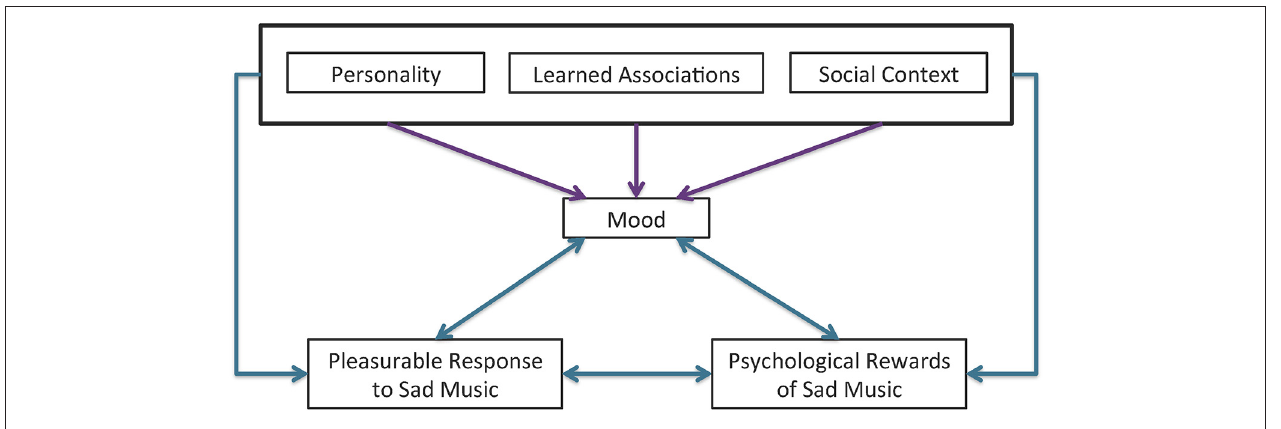
associated with sad music and, ultimately, the pleasurable response (blue arrows). The resulting pleasurable response can in turn influence current mood, as represented by the bi-directional arrow between pleasure and mood. The reciprocal nature of psychological rewards and pleasurable response is also represented by a bidirectional